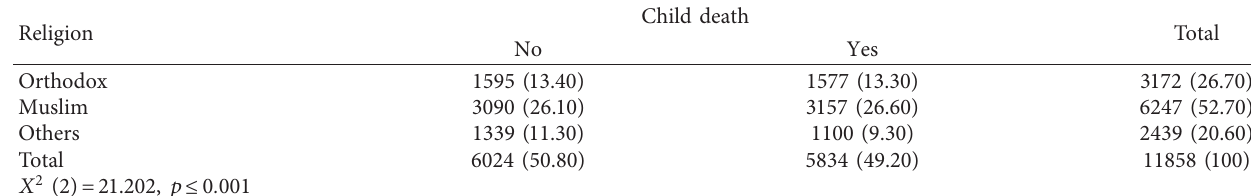
Table 12: Religious beliefs on child mortality.